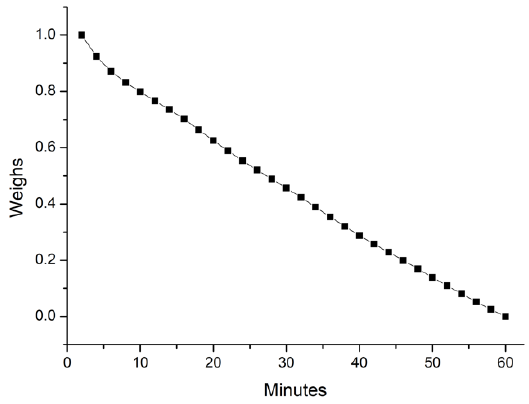
Figure 7. Trend of weights along with the time lag.